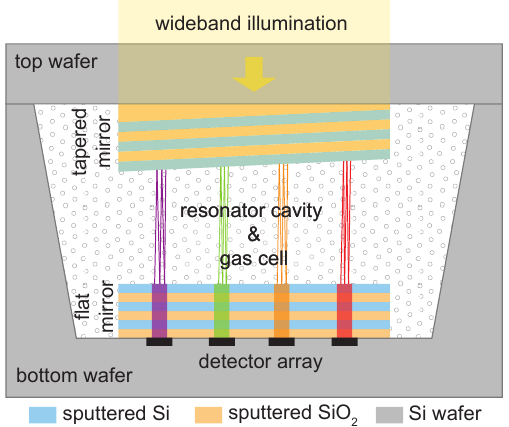
Figure 1. Side view of the gas-filled linear variable optical filter (LVOF), composed of a flat and a tapered mirror with a tapered resonator cavity